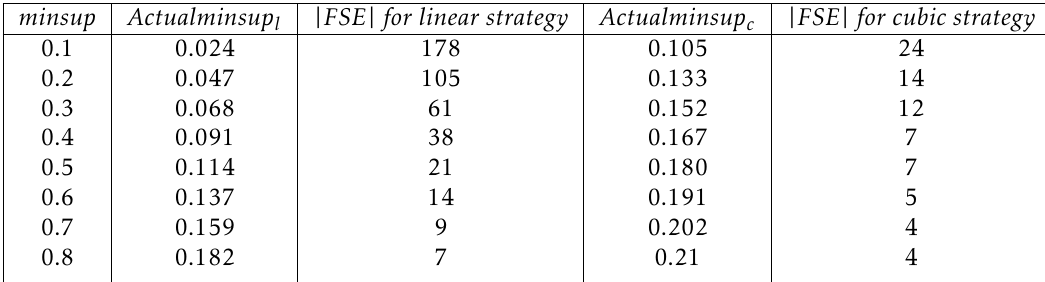
Table 16. Number of frequent singleton edges (|FSE|) for paths data using proposed static approach with actual minimum support using linear strategy and cubic strategy